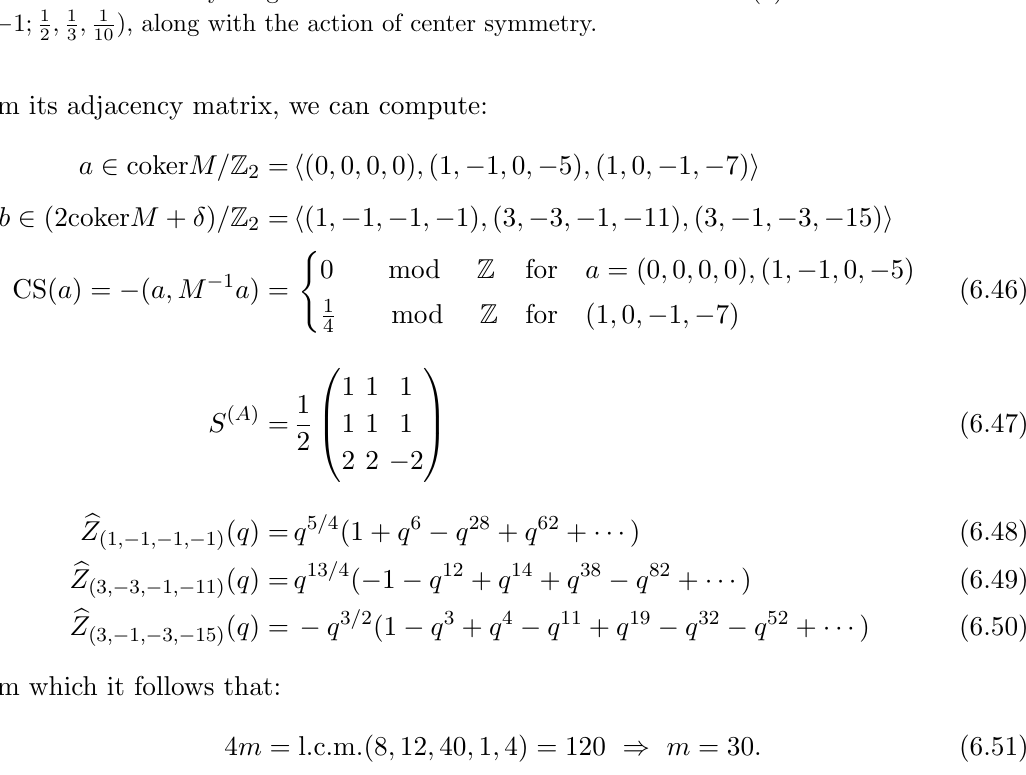
Table 7 . Holonomy angles and Chern-Simons invariants of SU(2) (cid:13)at connections